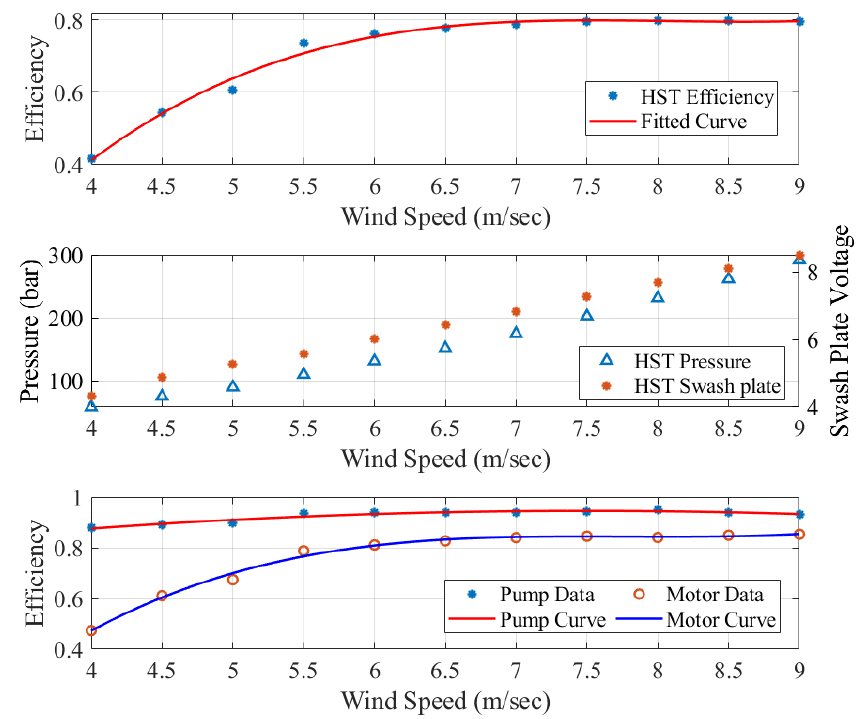
Figure 12. Efficiency of the HST wind